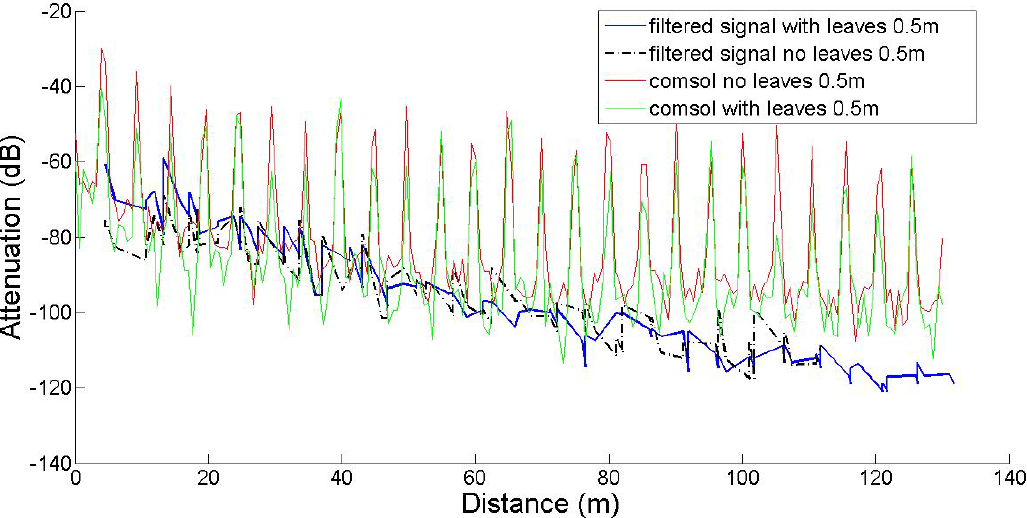
Figure 7. Attenuation computations and measurements for transmitter and receiver height equal to h = 0.5